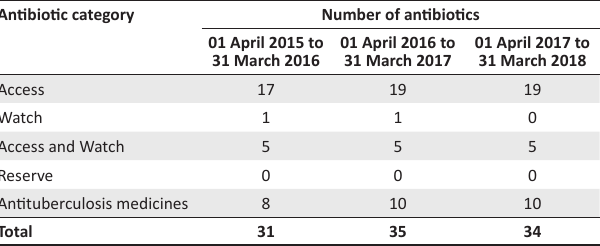
TABLE 3: Procured antibiotics are categorised according to the World Health Organization Model List of Essential Medicines. 25 Antibiotic category